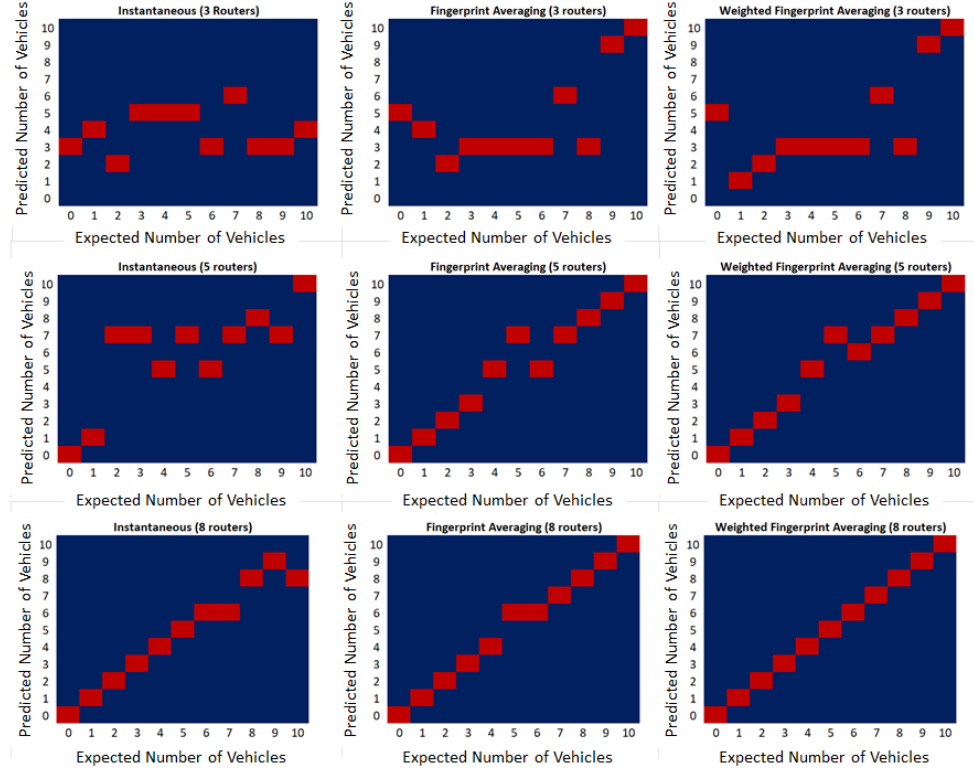
Figure 6. Comparing prediction accuracy employing instantaneous ( left column), averaging method ( center column), and weighted averaging ( right